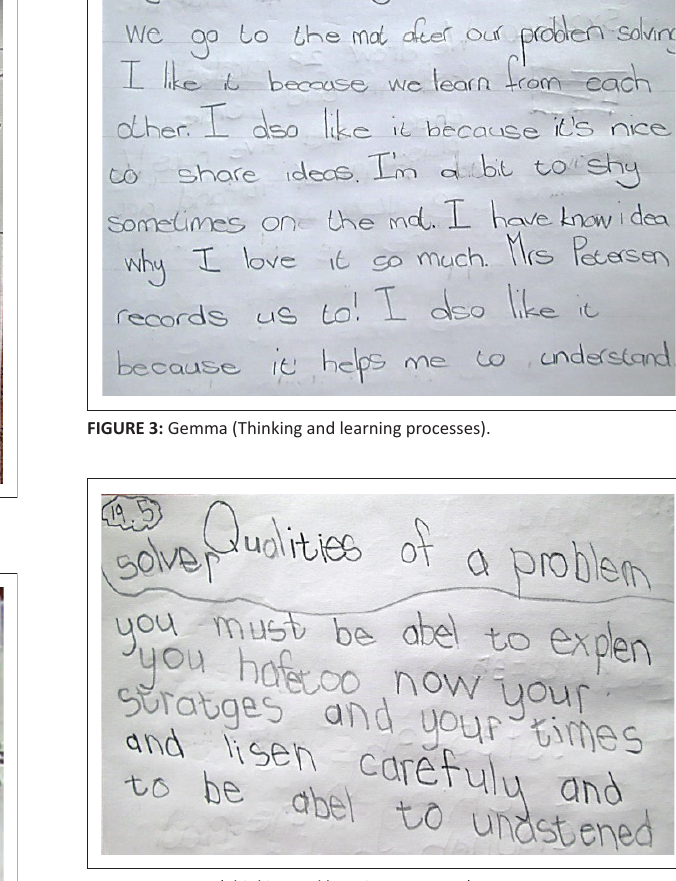
FIGURE 4: Bevan (Thinking and learning processes).